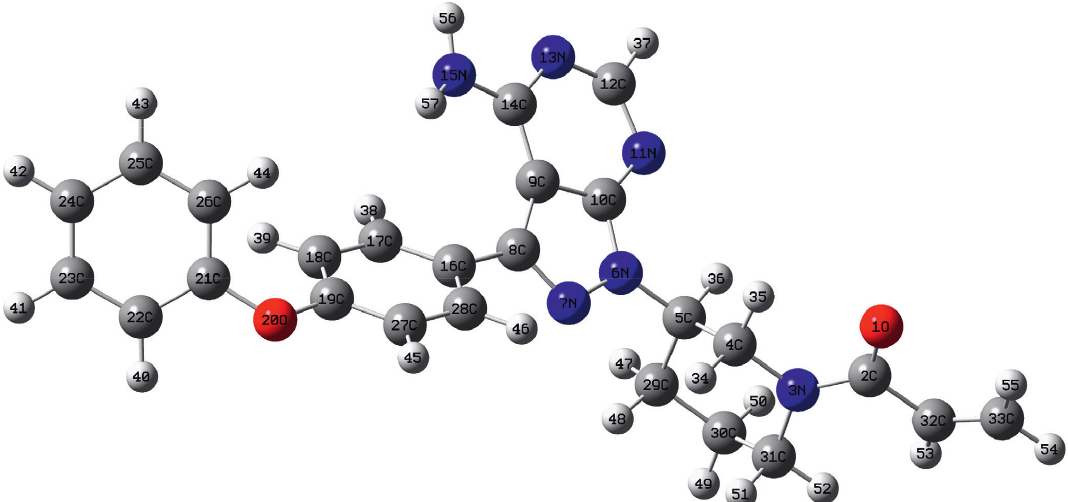
Figure 1: The optimized structure of ibrutinib using high-level density functional theory to identify bond length and bond angles.